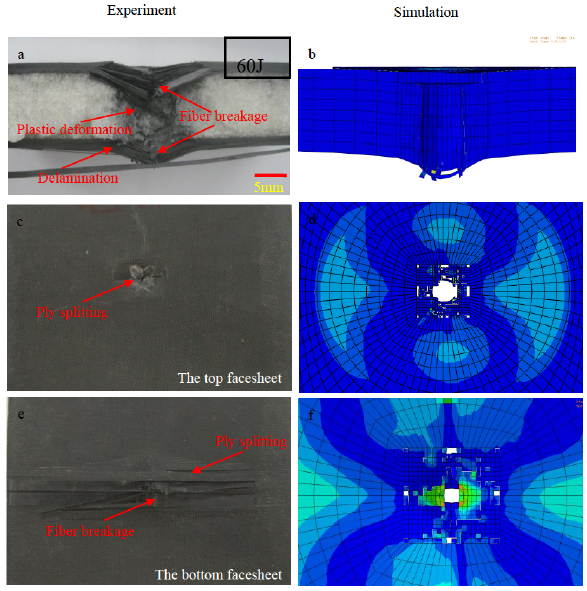
Figure 13: Impact damage of experimental and FEM simulation of foam sandwich composite at the impact energy of